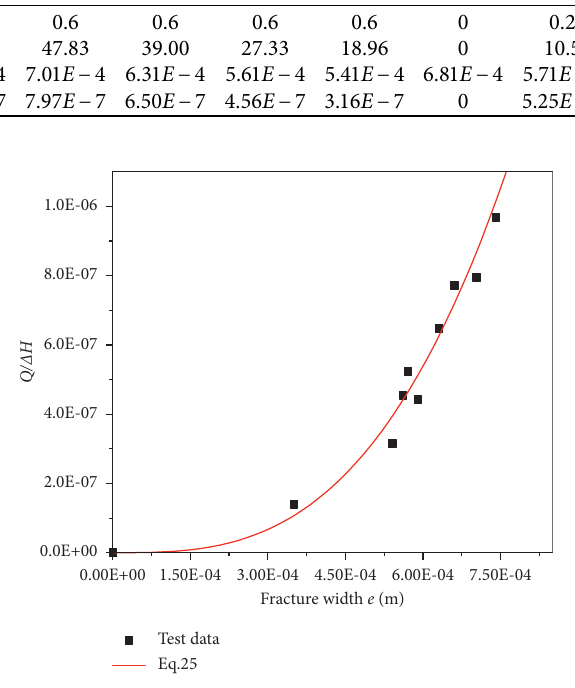
Figure 18: The measured flow and equation (15) fitting contrast Table 7: Relationship between calculated flow and simulated flow under different working conditions.